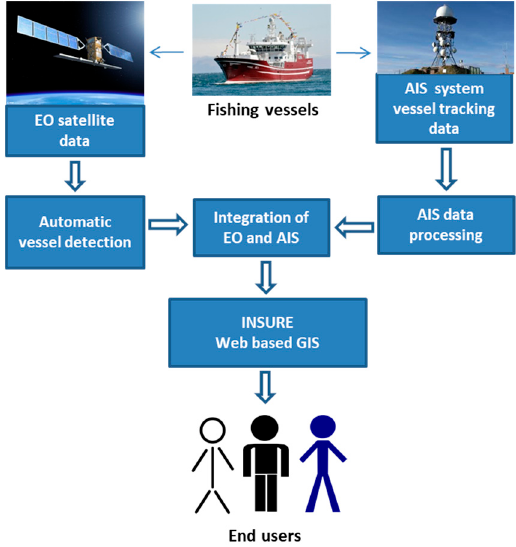
Figure 1. Schematic diagram of the INSURE system and its components.